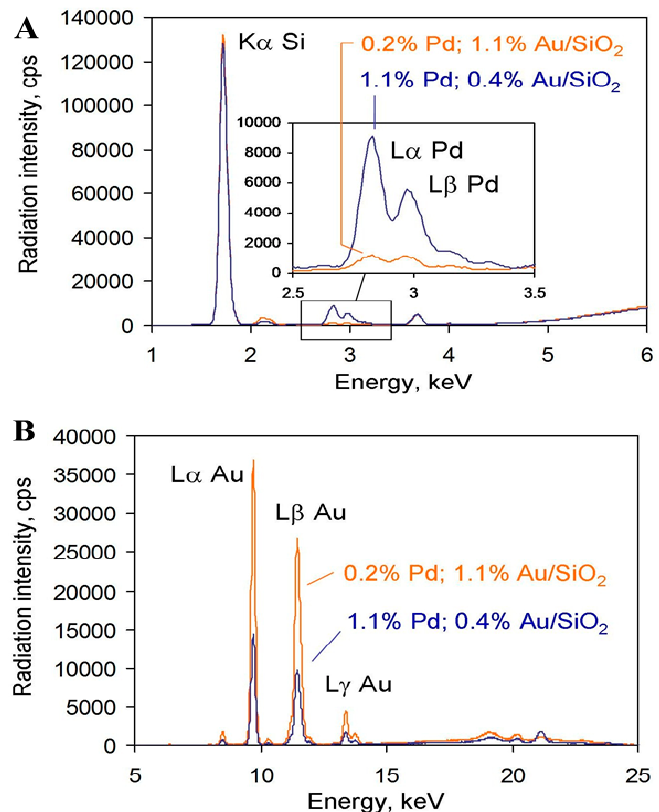
Figure 1. EDDXRF spectra of (1.1% Pd; 0.4% Au)/SiO 2 and (0.2% Pd; 1.1% Au)/SiO 2 . Measurement conditions: ( A ) 12 kV, 750 µ A, 50 µ m Al primary beam filter, 300 s counting time, helium; ( B ) 30 kV,